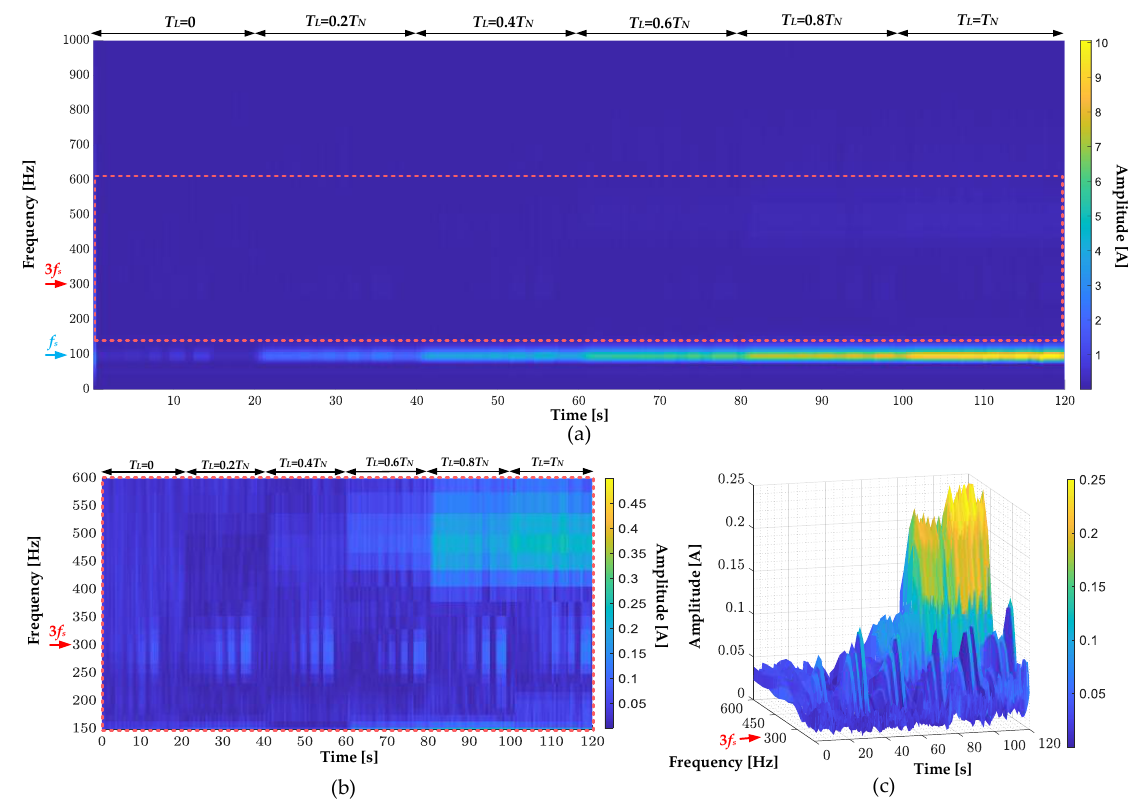
Figure 6. ( a ) CWT scalogram of the stator phase current waveform; ( b ) 2D and ( c ) 3D scalograms of the stator phase current waveform for narrowed frequency and colormap range ( T L = var, f s = f sN = 100 Hz).